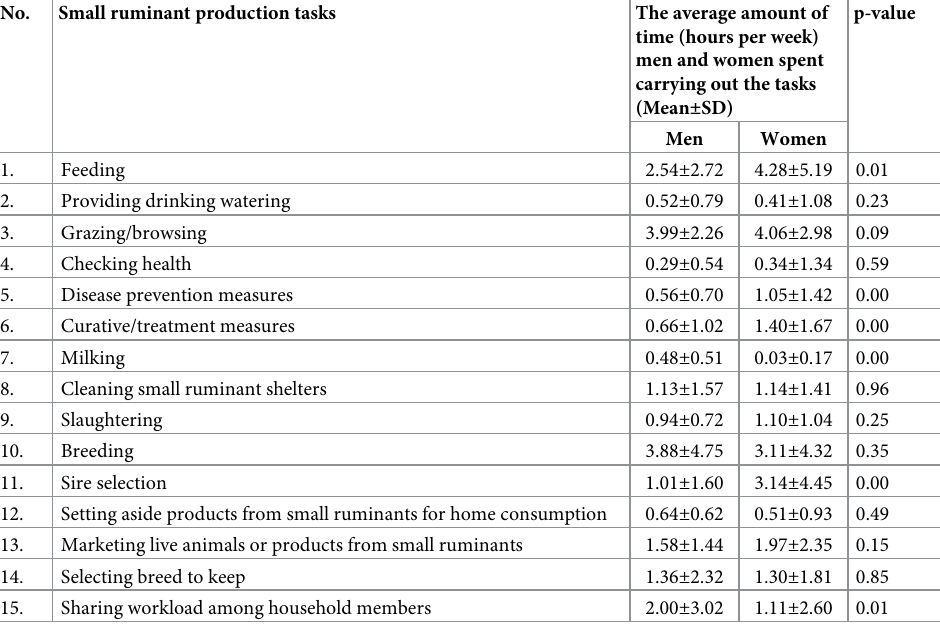
Table 6. Time (hours) spent per week by men and women performing different production